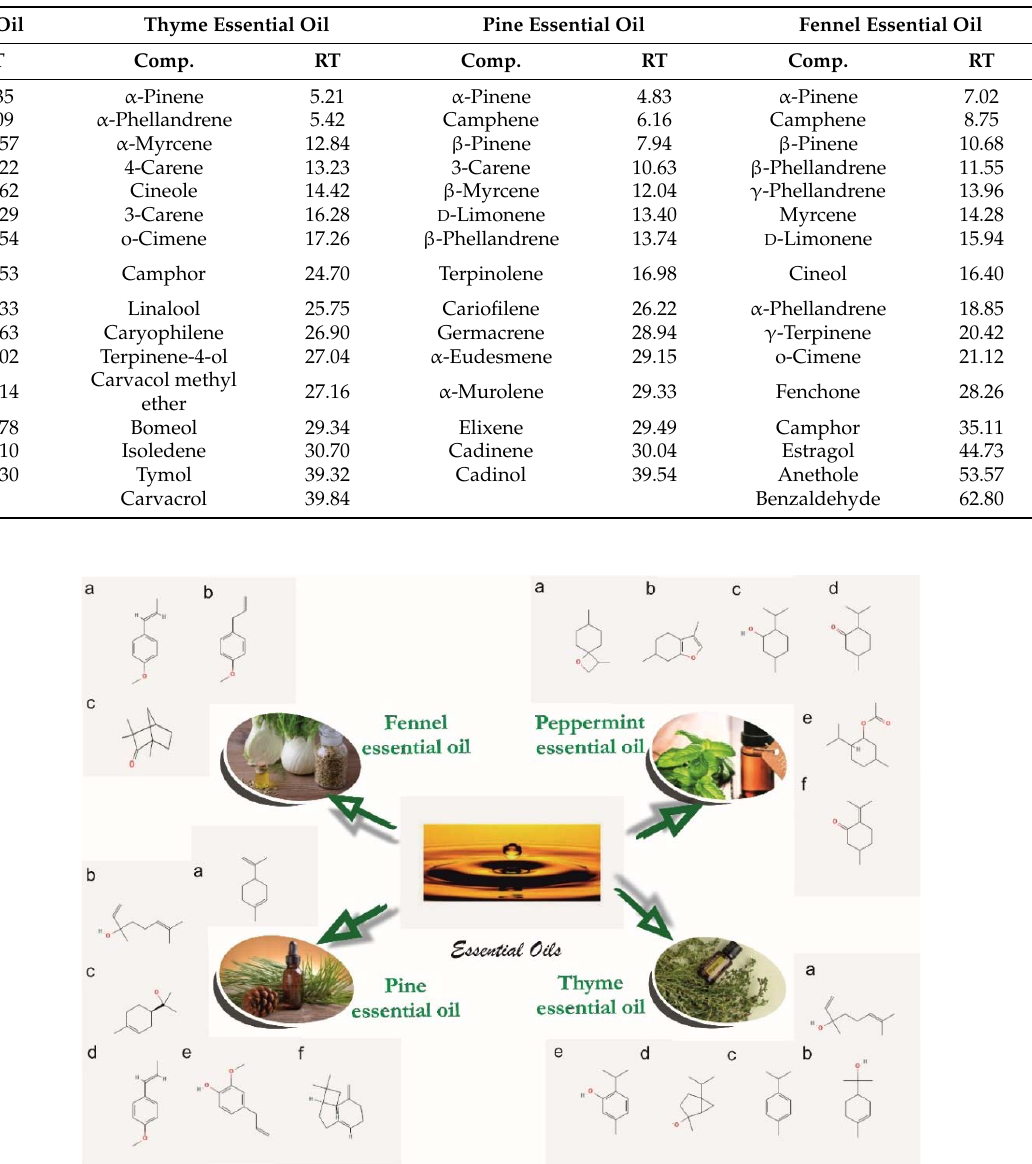
Table 3. Composition of fennel, peppermint, pine, and thyme essential oils determined by gas chromatography coupled with a mass spectrometer (GC-MS).